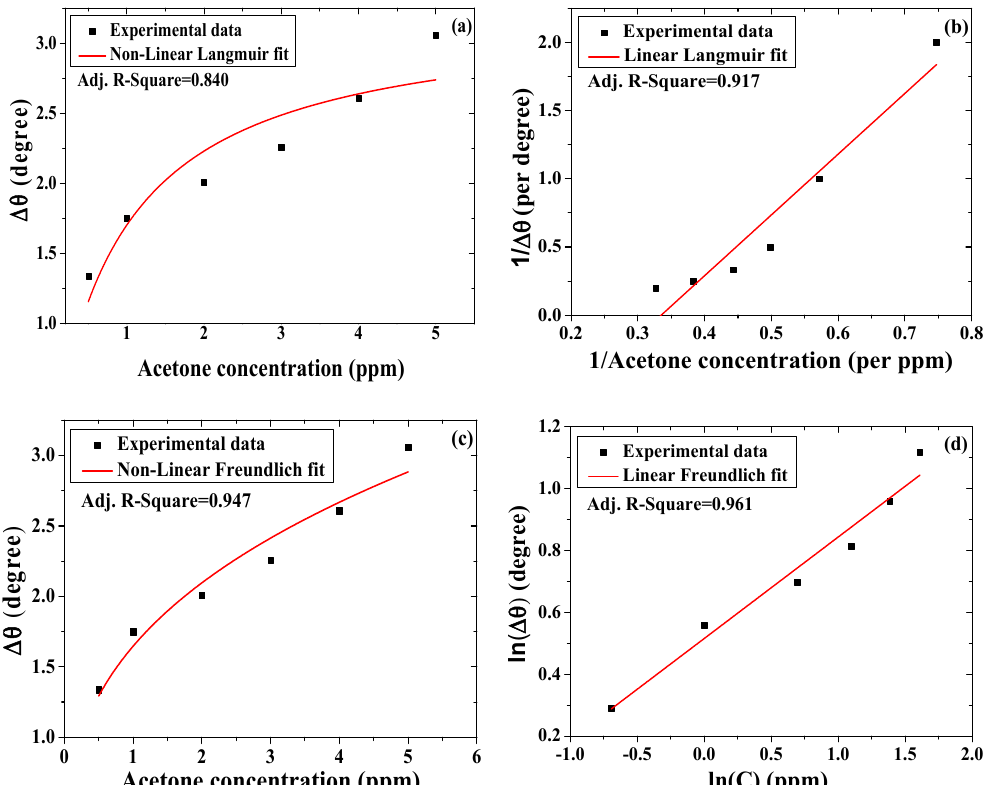
Figure 9. Binding affinity between the single-layer chitosan-PEG-based SPR sensor and various acetone concentrations fitted to ( a ) nonlinear Langmuir, ( b ) linear Langmuir, ( c ) nonlinear Freundlich, and ( d ) linear Freundlich isotherms models.